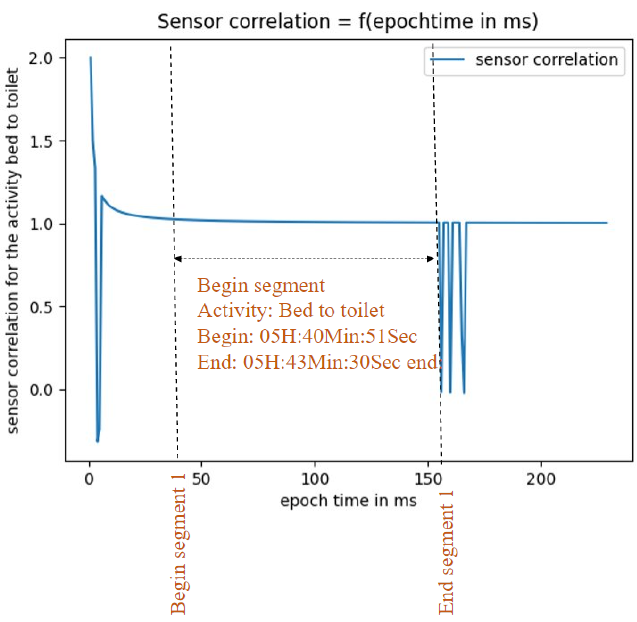
Figure 10. Corresponding segment of the activity “bed to